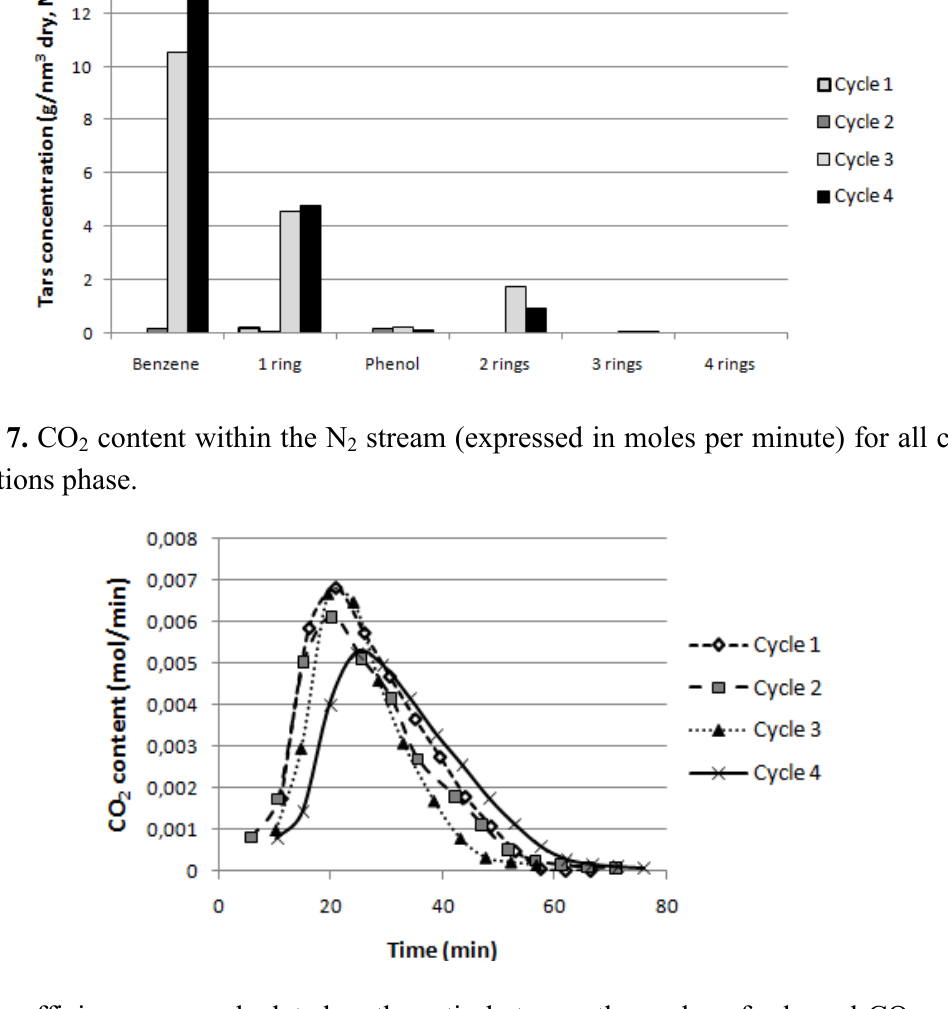
Figure 6. TAR concentration (g/Nm 3 dry, N